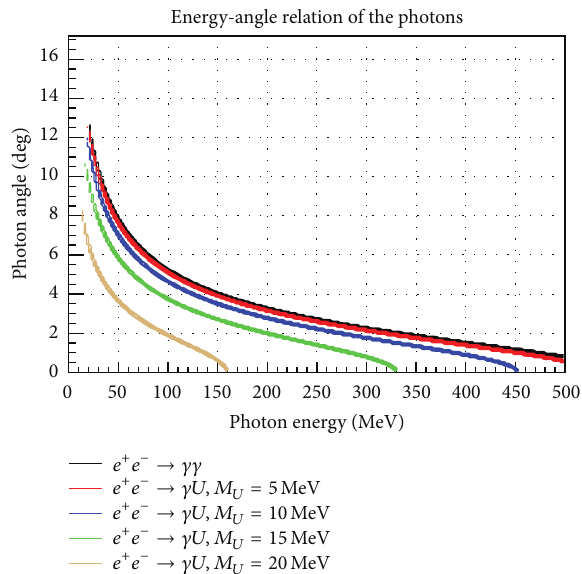
Figure 14: Gamma energy versus the opening angle for 𝑒 + 𝑒 − → 𝛾𝛾 or → 𝑈𝛾 for different 𝑈 boson masses. Beam energy is 550 MeV.